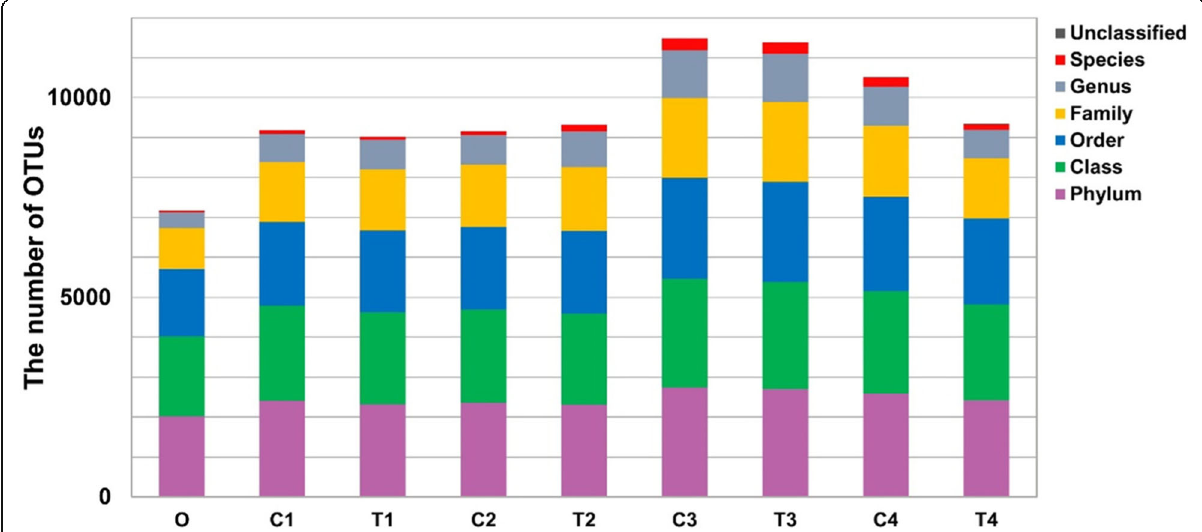
Fig. 2 The number of OTUs of soil in maize rhizosphere in different periods. Note: O indicate that the soil at the time of planting; C1 indicate that the rhizosphere soil at the time of the three-leaf stage of control; C2 indicate that the rhizosphere soil at the time of the jointing stage of control; C3 indicate that the rhizosphere soil at the time of the tasseling stage of control; C4 indicate that the rhizosphere soil at the time of the maturity stage of control; T1 indicate that the rhizosphere soil at the time of the three-leaf stage of P8/P10/X52; T2 indicate that the rhizosphere soil at the time of the jointing stage of P8/P10/X52; T3 indicate that the rhizosphere soil at the time of the tasseling stage of P8/P10/X52; T4 indicate that the rhizosphere soil at the time of the maturity stage of